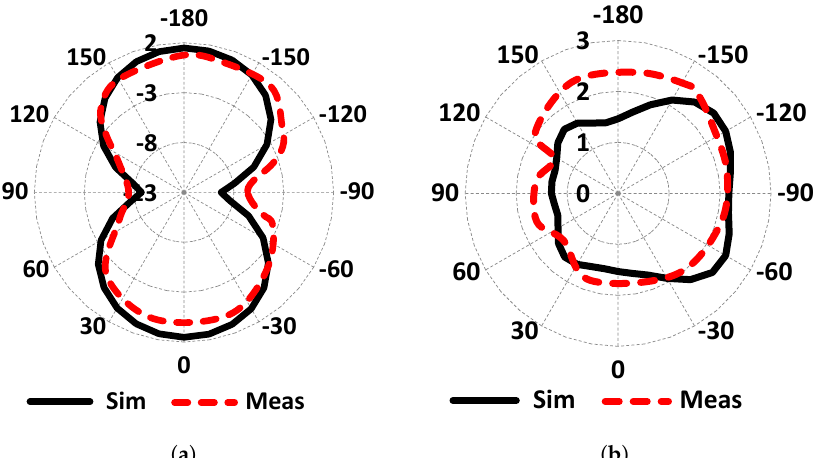
Figure 9. Simulated and measured radiation patterns of the proposed MIMO design, ( a ) E-plane, ( b )